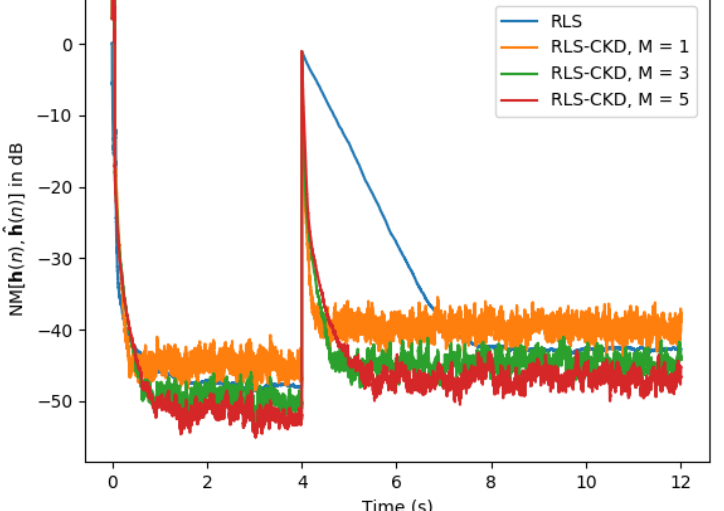
Figure 7. Normalized misalignment of the classical RLS ( L = 512) and RLS-CKD ( L 1 = 64, L 2 = 8) algorithms. The input signal is white Gaussian noise and the impulse response changes after 4 s of